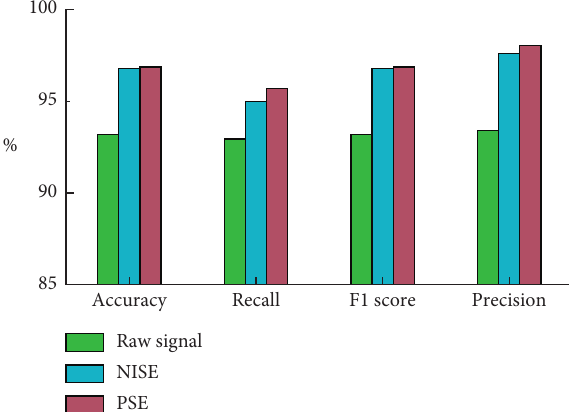
Figure 18: Comparison between different classifiers using NISE approach.